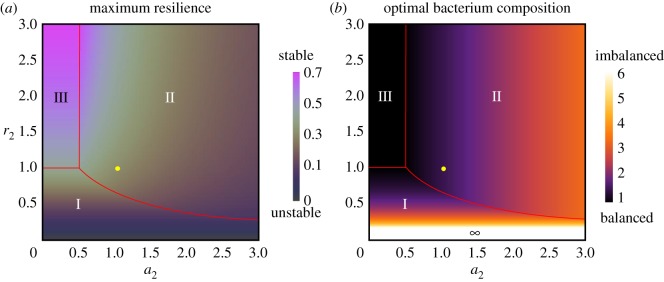
Maximum resilience Rmax (a) and optimum microbial composition Xopt (b) in a focusing equilibrium. We assumed r1 = a1 = 1. Contours in (a) indicate the values of Rmax in phases I, II and III, which are equal to r2/2, 2a1r1r2/(2a2r2 + r2 + 2a1r1) and r2r1/(r2 + r1), respectively (electronic supplementary material, S1). Contours in (b) indicate the values of Xopt in phases I, II and III, which are equal to r1/r2 (2a2 + 1)/2a1 and 1, respectively (electronic supplementary material, S1). In the region with lower values of r2 in (b), Xopt has a much higher value. Parameter values are the same as those shown in figure 2a. The position of r1 = a1 (=1) is indicated by the yellow circles.